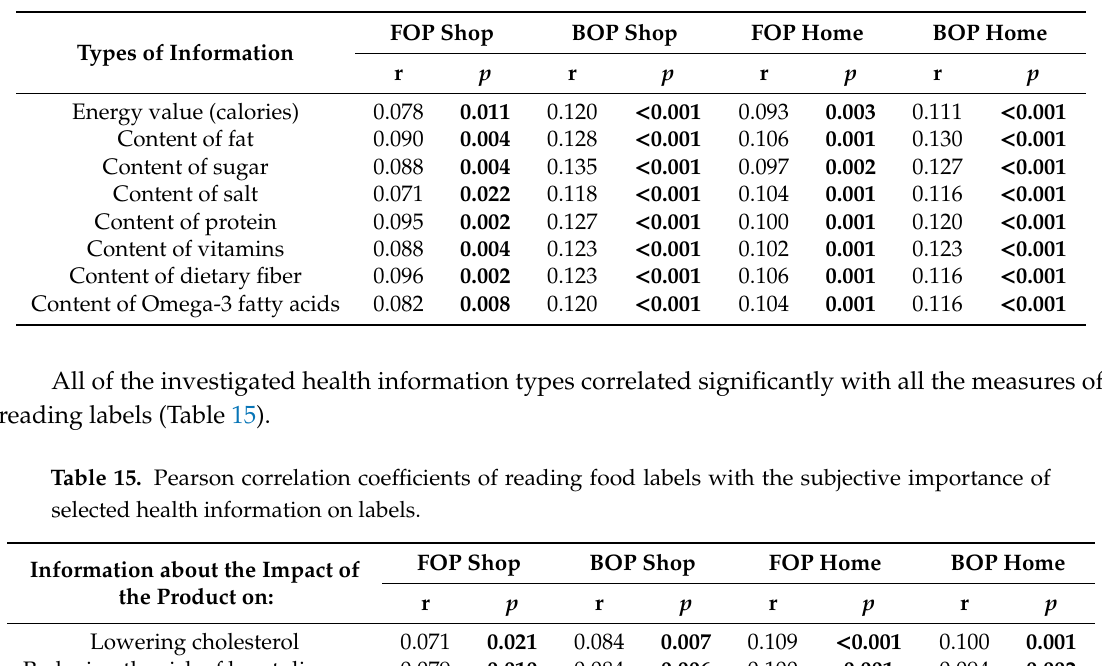
Table 14. Pearson correlation coe ffi cients of reading food labels with the subjective importance of selected nutritional information on labels.